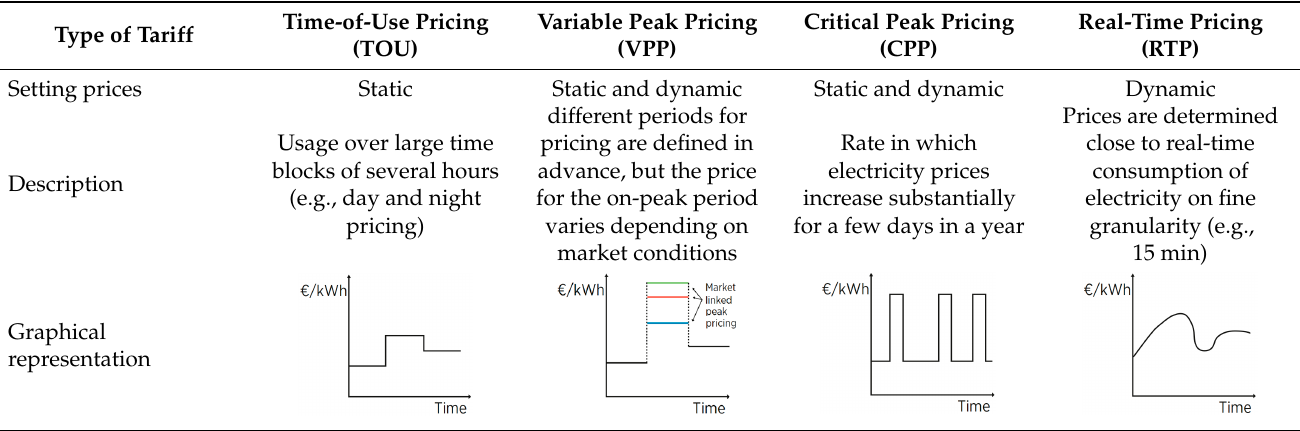
Table 2. Smart charging based on price signals [9,10].